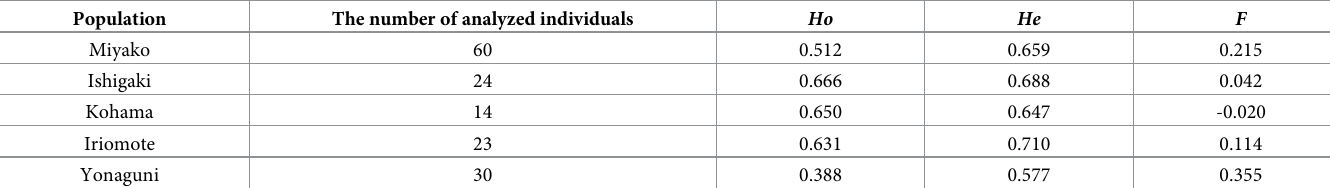
Table 2. Genetic diversity of microsatellites. Population The number of analyzed